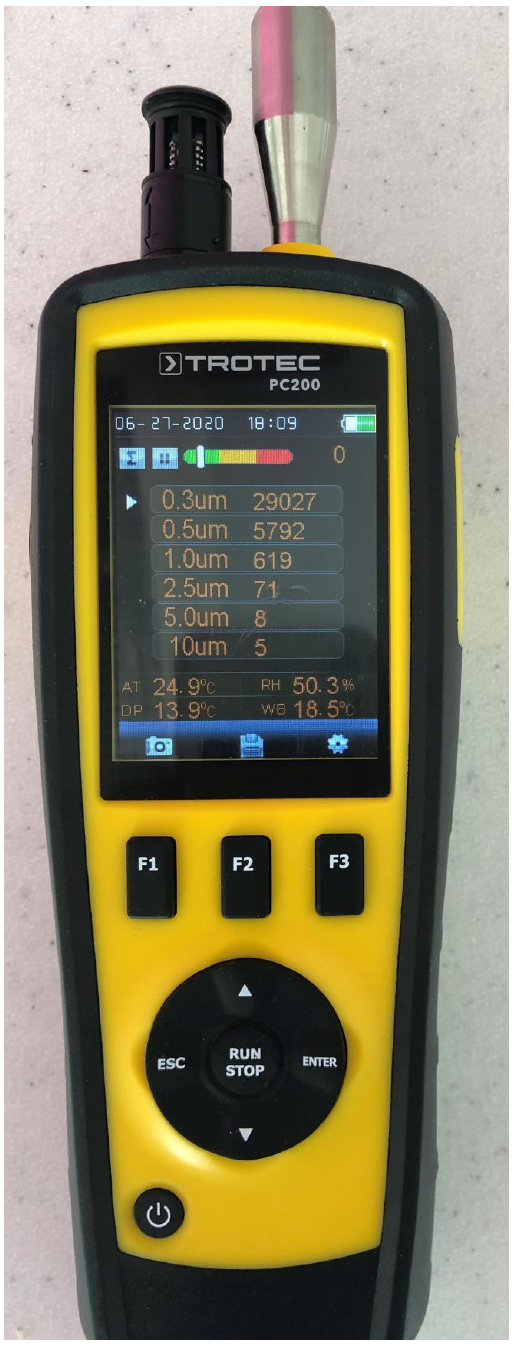
Figure 3. Particle sensor PC200 (Trotec GmbH, Schwerin, Germany) used in the experiment.